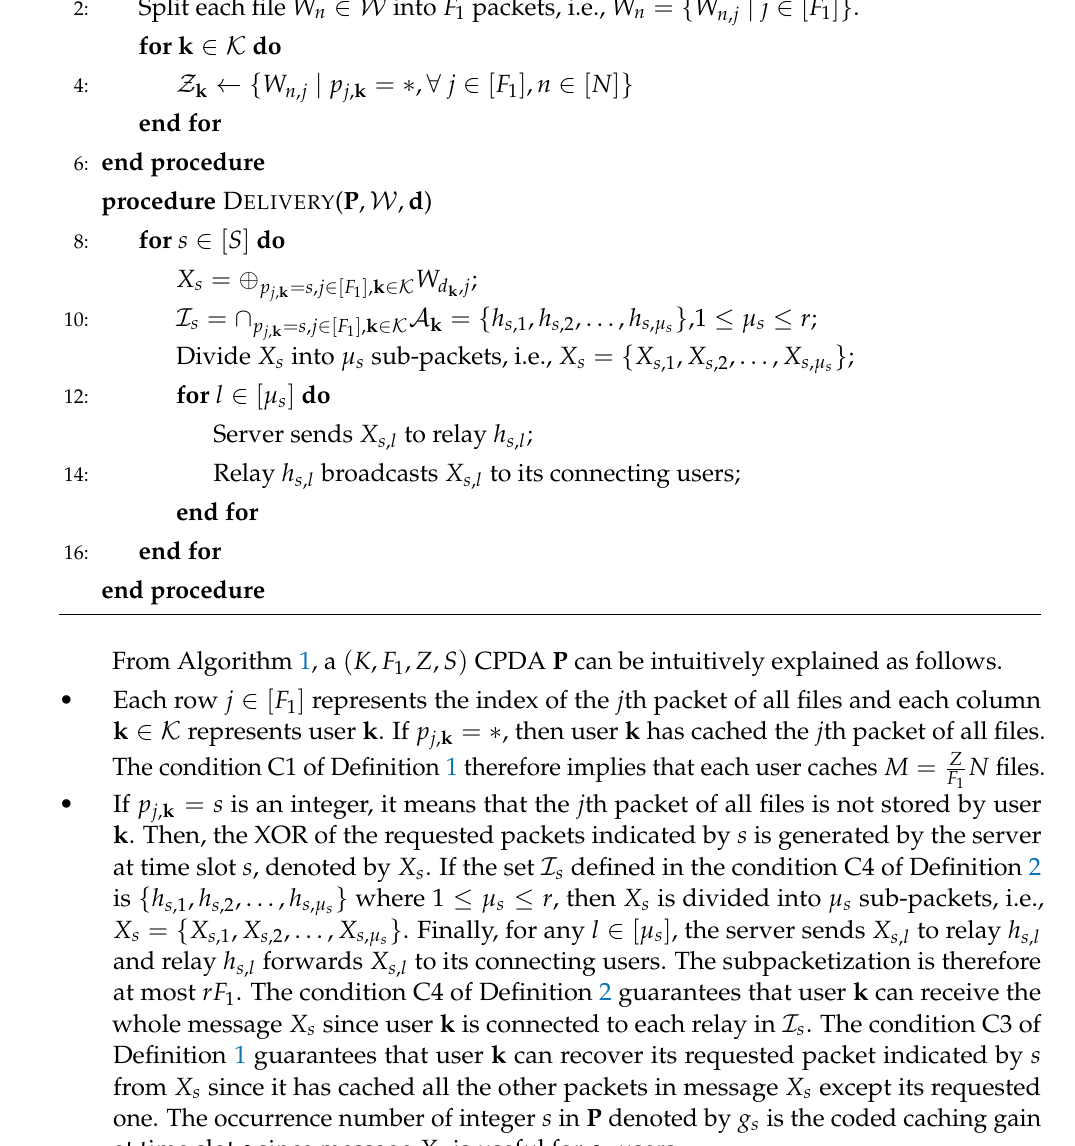
Algorithm 1 Caching scheme based on ( K , F 1 , Z , S ) CPDA in [15] procedure P LACEMENT ( P , W